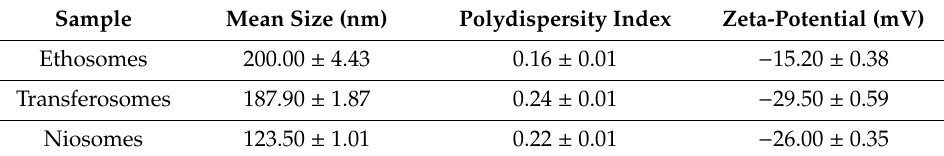
Table 1. Physico-chemical parameters of drug delivery systems obtained by use Zetasizer Nano ZS. Values are reported as the average of three independent experiments ± standard